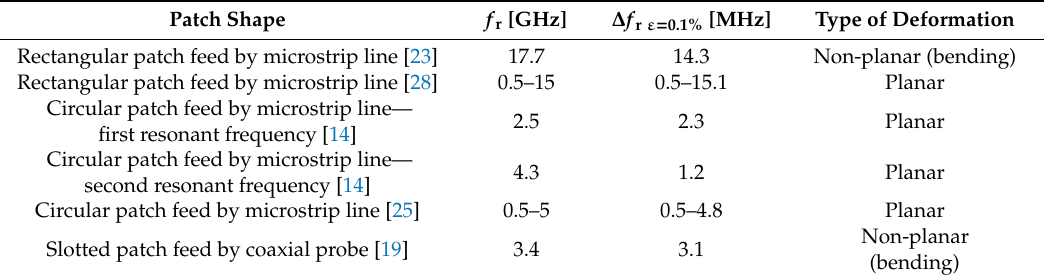
Table 1. Comparison of microstrip